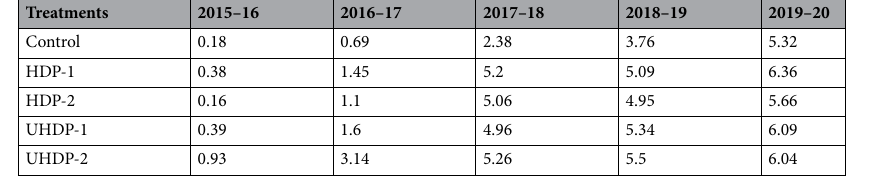
Table 6. Effect of planting density on benefit: cost (B:C) ratio. Control: Planting at 6 m (row to row) × 6 m (plant to plant) spacing (tree density—277 plants ha −1 ), HDP-1: Planting at 6 m (row to row) × 3 m (plant to plant) spacing (tree density—555 plants ha −1 ), HDP-2: Planting at 4 m (row to row) × 4 m (plant to plant) spacing (tree density—625 plants ha −1 ), UHDP-1: Planting at 4 m (row to row) × 2 m (plant to plant) spacing (tree density—1250 plants ha −1 ), UHDP-2: Planting at 2 m (row to row) × 2 m (plant to plant) spacing (tree density—2500 plants ha −1